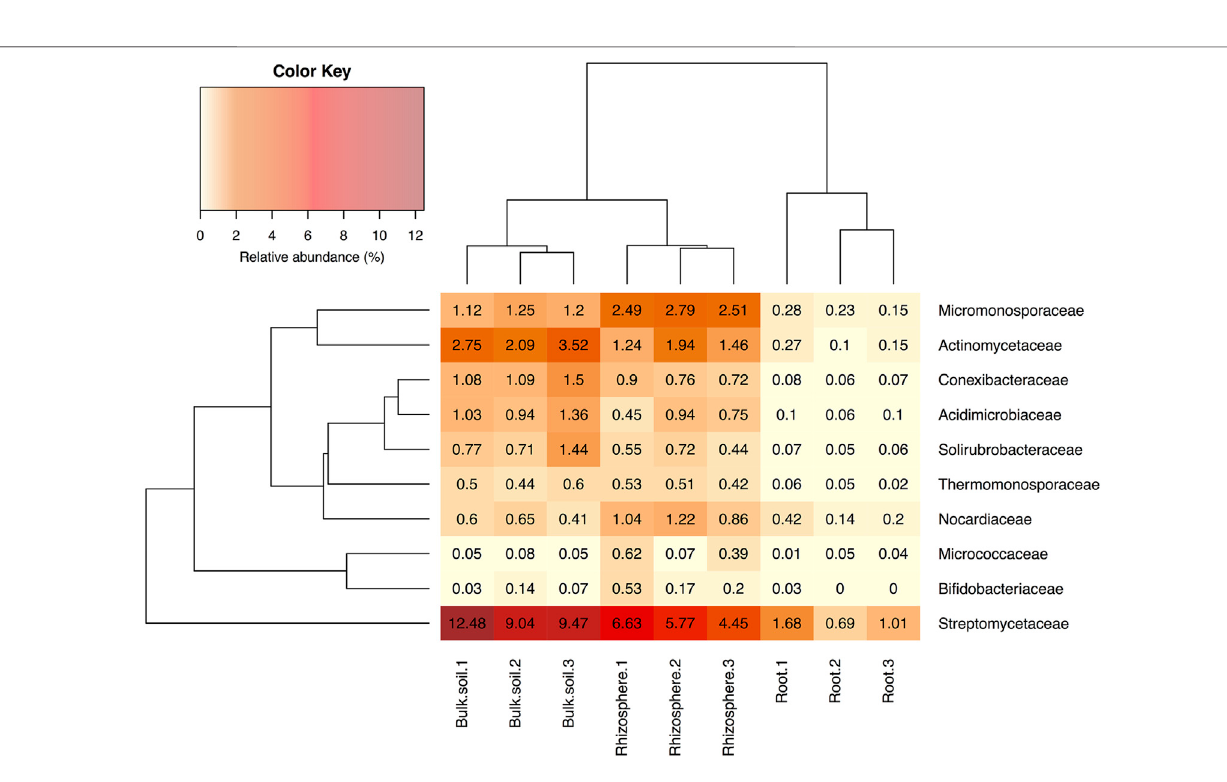
Frontiers in Molecular Biosciences |